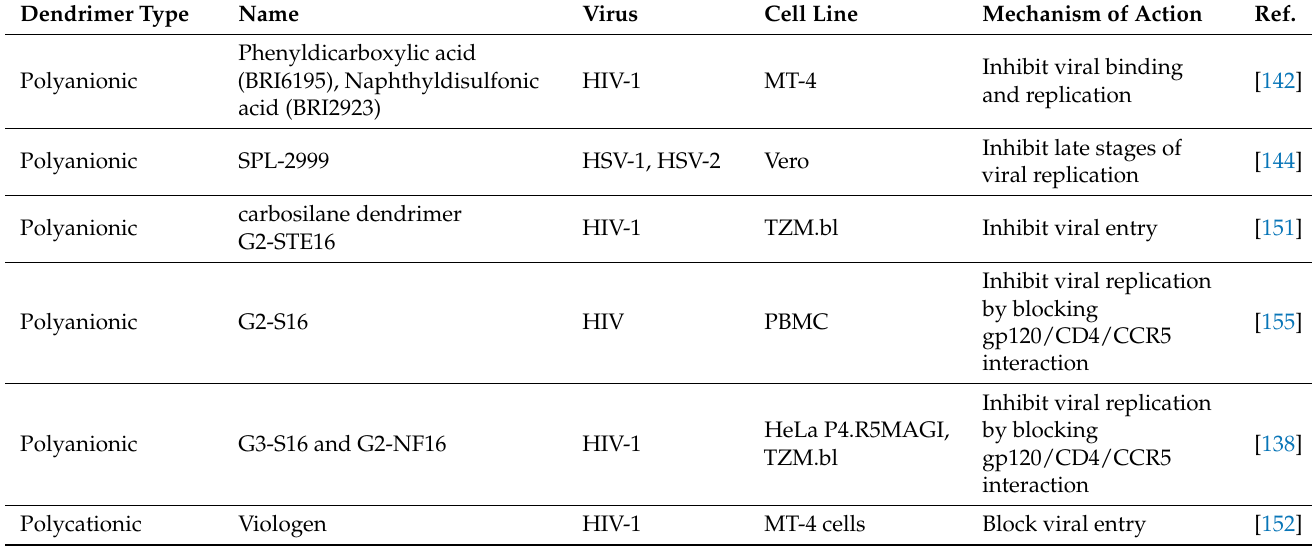
Table 6. Antiviral activity of dendrimers and their mechanisms of